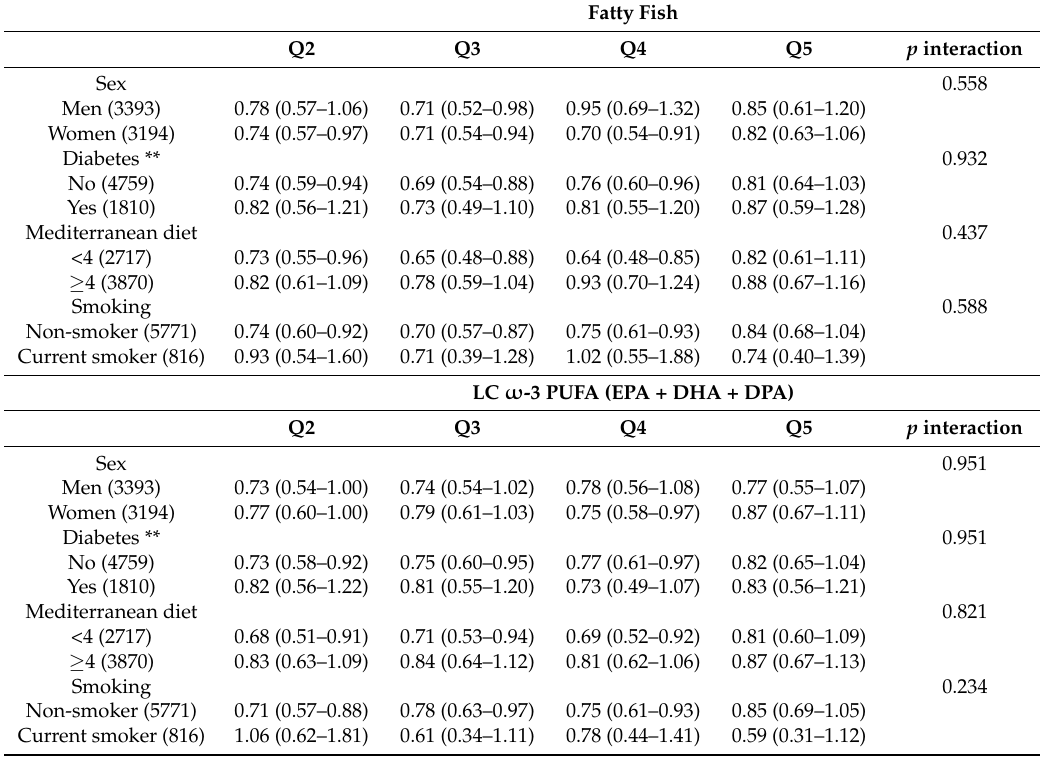
Table 5. OR * and 95% CI for the association between energy-adjusted fatty fish consumption and LC ω -3 PUFA intake (quintiles) and life-time prevalence of depression in the PREDIMED-Plus trial according to different characteristics of the